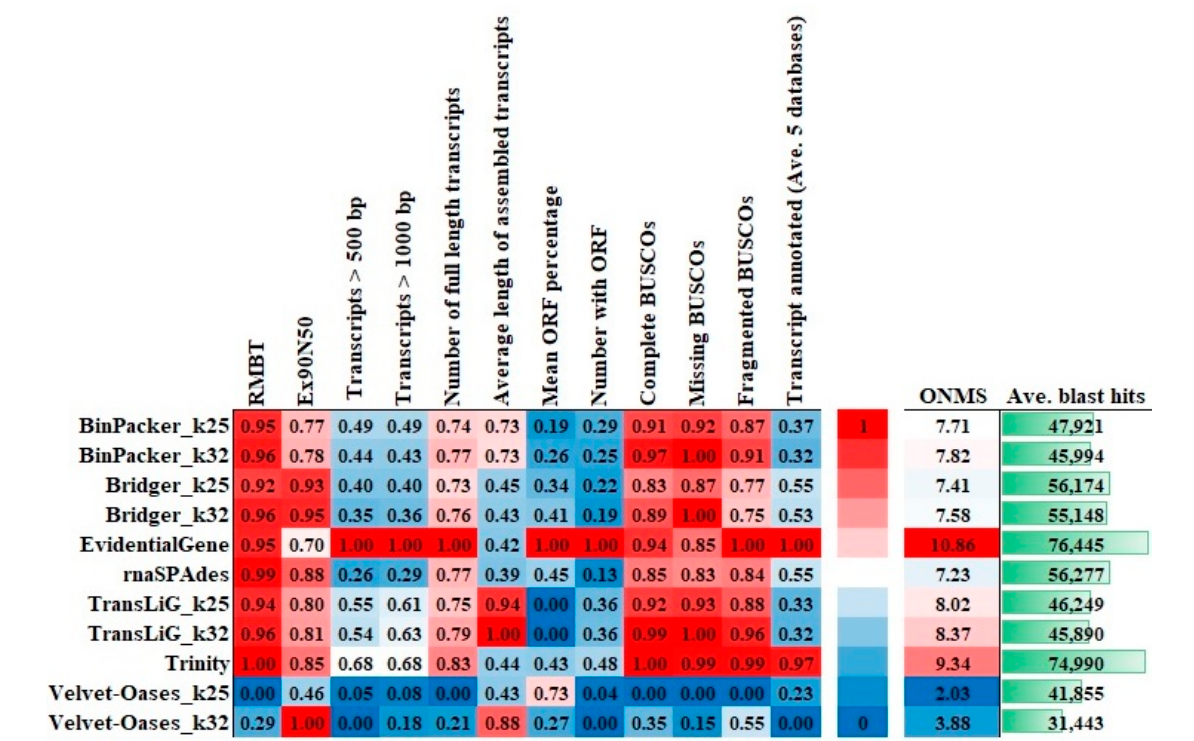
Figure 7. Results for overall normalized metric score assessment.